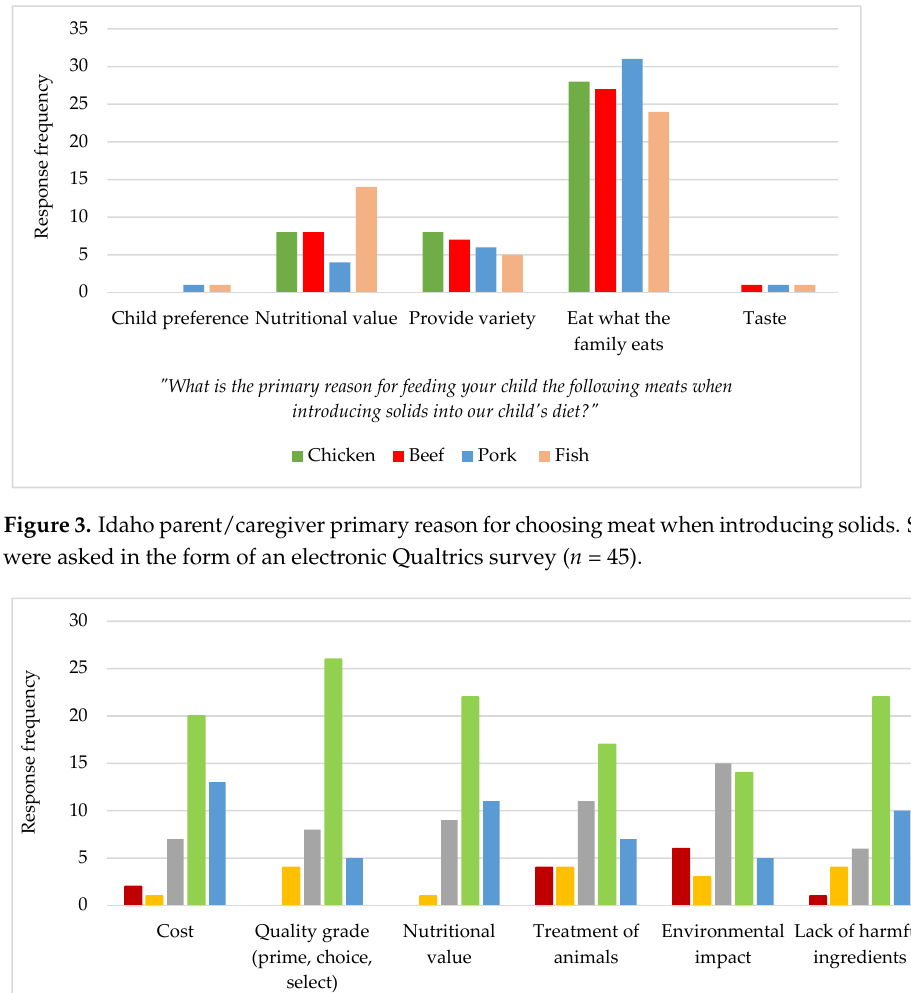
Figure 2. Idaho parent/caregiver’s perception of beef and other foods as a good source of zinc/iron for infants. Subjects were asked in the form of an electronic Qualtrics survey ( n = 61). In the sample of 61 Idaho parents/caregivers, 26% of respondents did not introduce meats into their child’s diet at 6–12 months of age. Of those who did introduce meat, the most com-